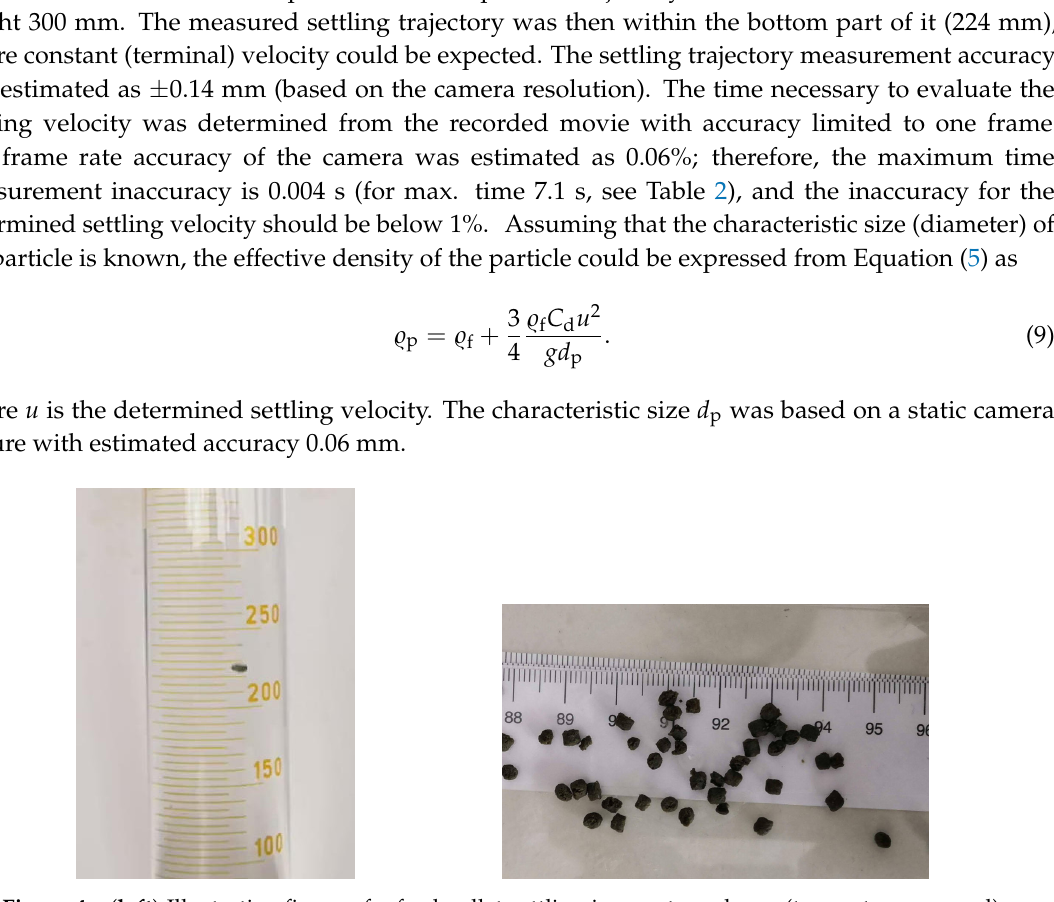
Figure 4. ( left ) Illustrative figure of a feed pellet settling in a water column (tap water was used). Table 2. Experimental results of settling velocity for TM0 pellets [17]. The resulting effective density of particles expressed from Equation (9) is 1054.4kg/m 3 ±